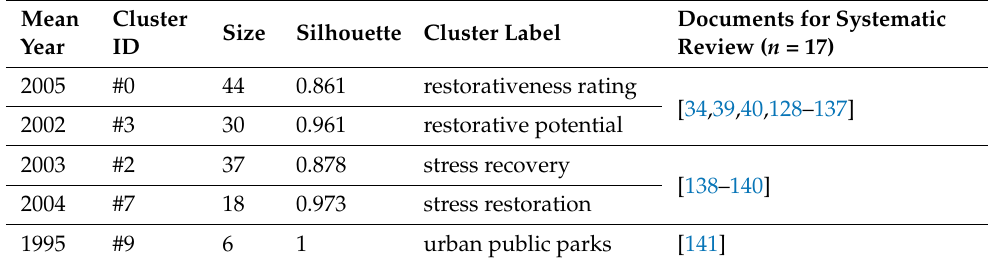
Figure 9. Co-citation clusters of the network for the second step of the review, visual stimuli, and visual properties of restorative environments. Table 8. Cluster information and documents for the second step of the systematic review, visual stimuli, and properties of restorative environments.